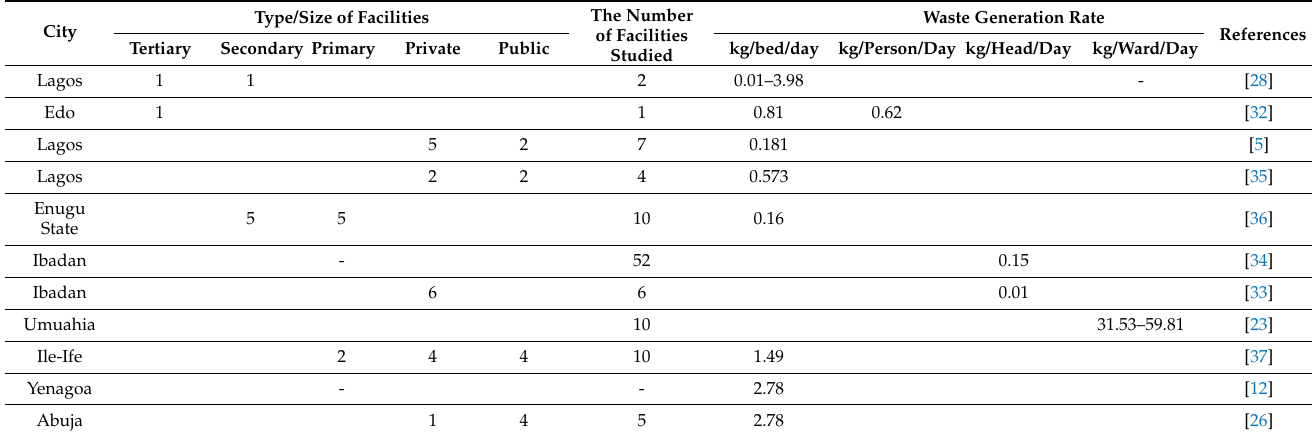
Table 1. Healthcare waste generation rates for locations across